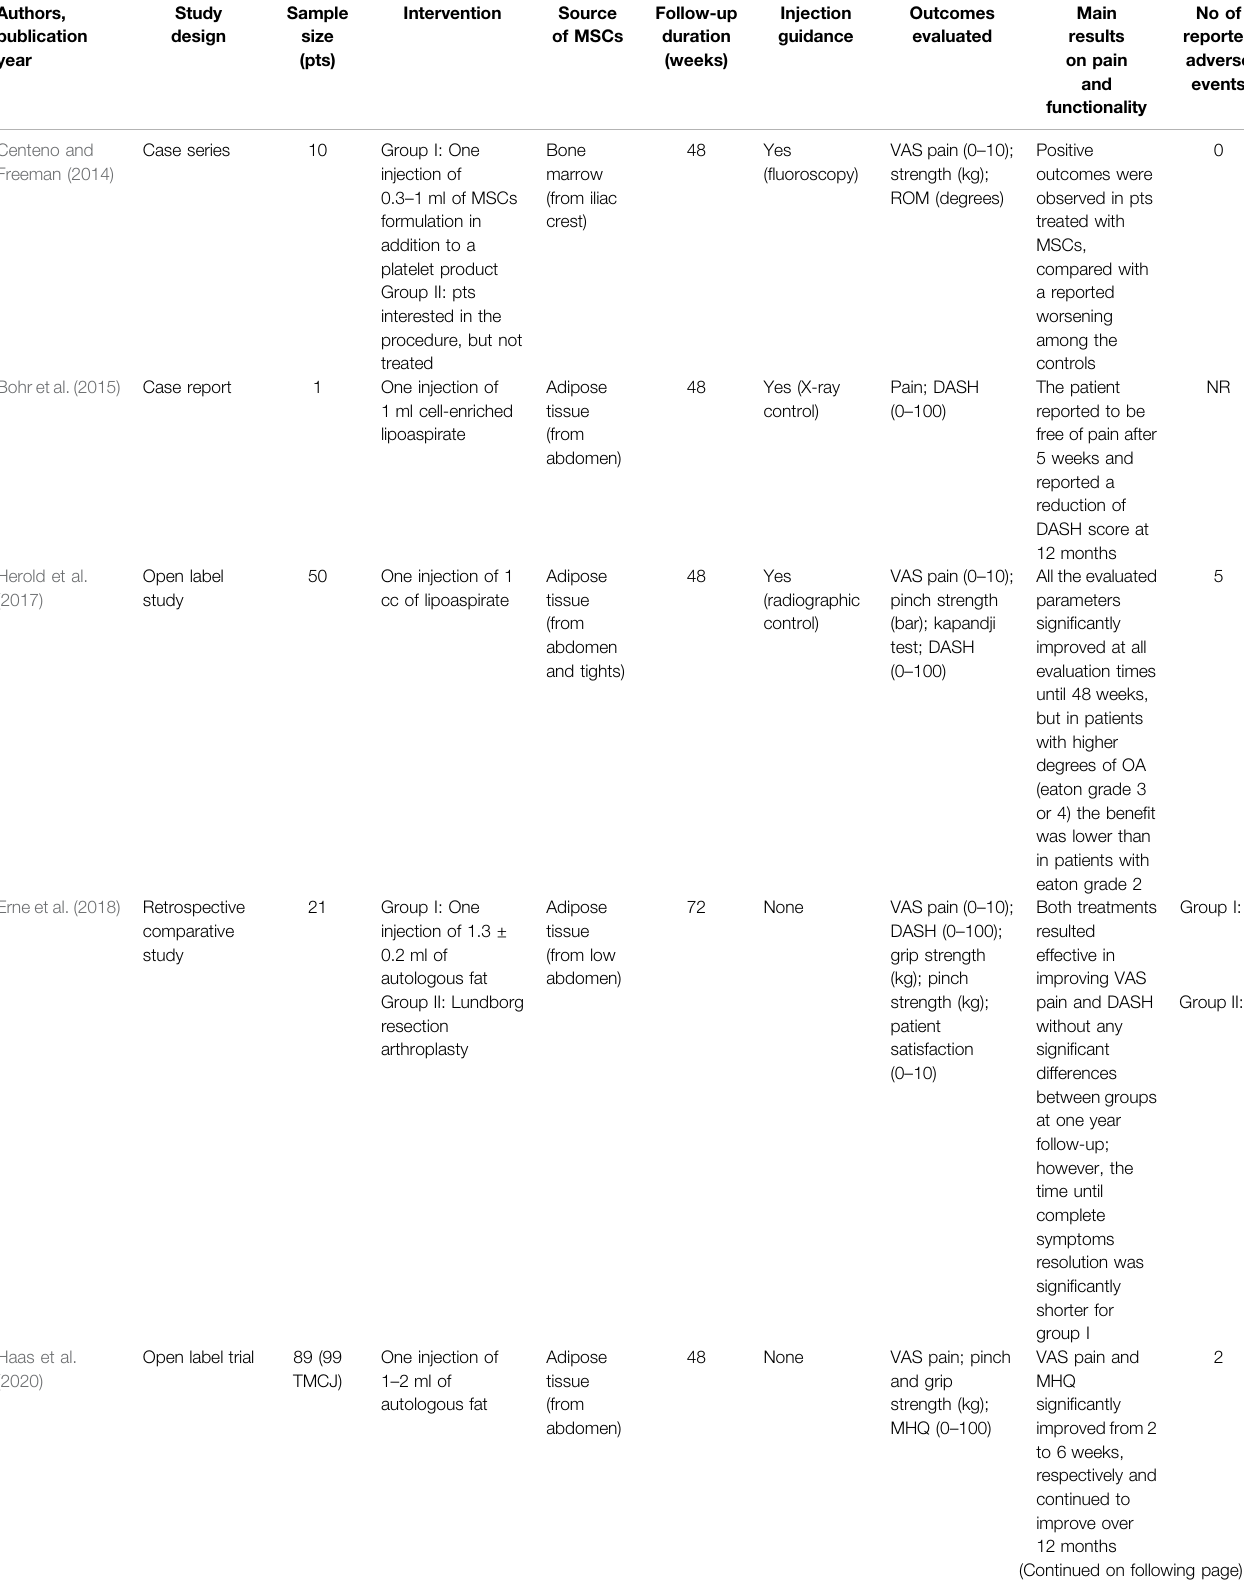
TABLE 4 | Summary of studies investigating intra-articular injections of mesenchymal-derived stem cell populations for the treatment of thumb-base